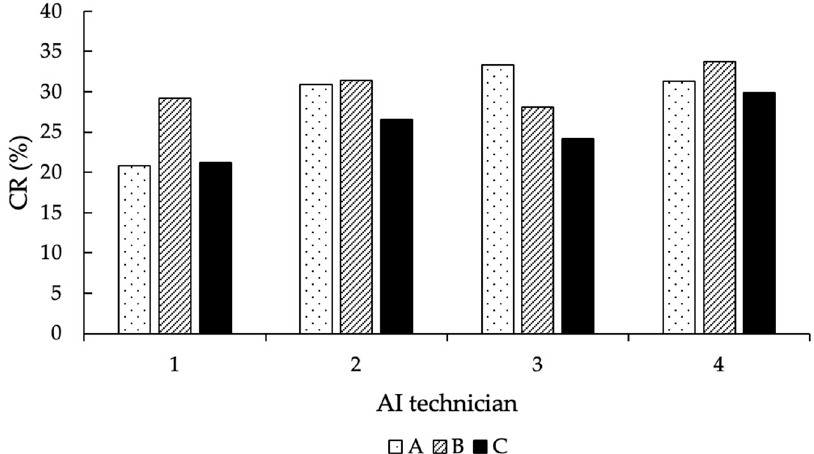
Figure 7. Distribution of the CR (in %) of the AI technicians, according to the thawing methods (A = 11 s, 38 °C water bath; B = 35 s, 38 °C water bath; C = 30 s, “in the cow”).